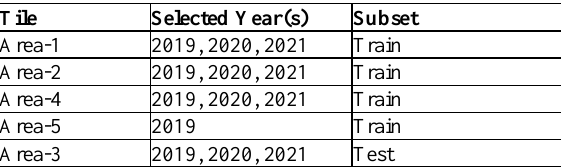
Table 2. The selected areas for the Experiment-1